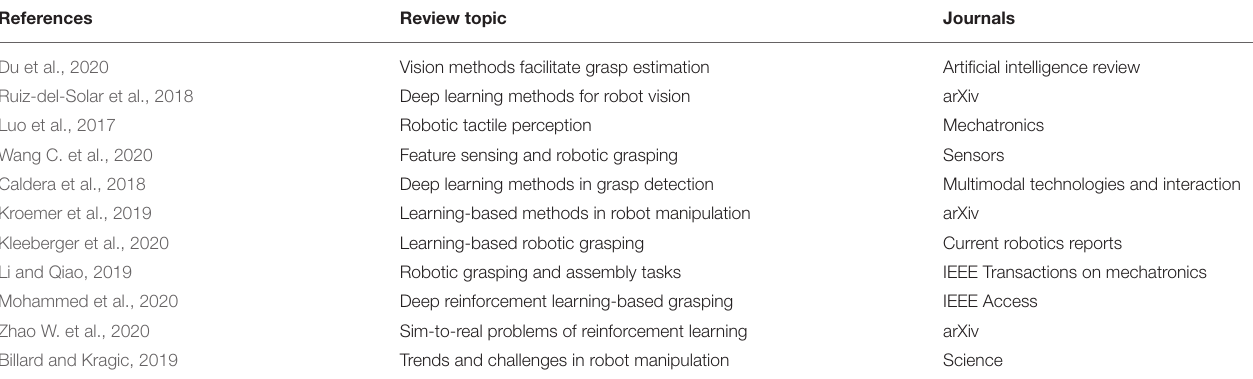
TABLE 1 | The related surveys and corresponding